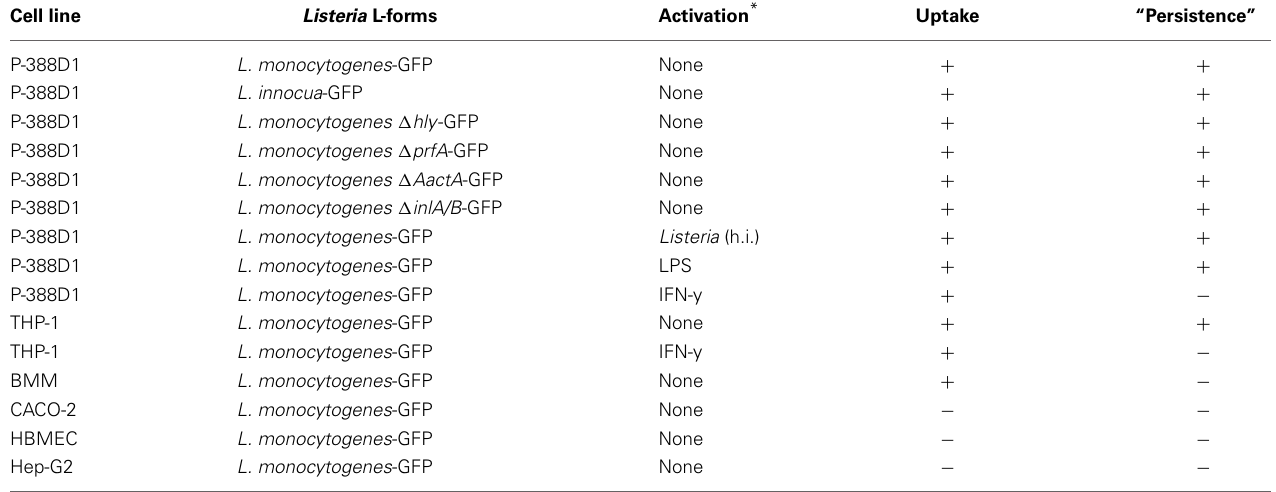
Table 2 | Challenge of various cell types with Listeria L-forms. Cell line